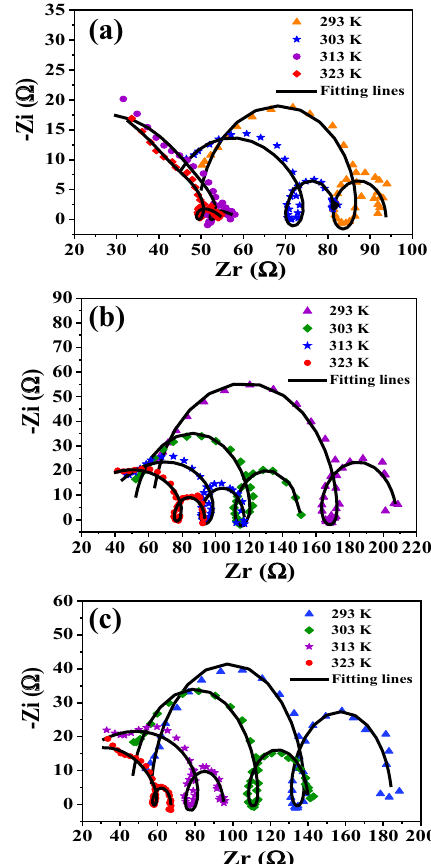
Figure 8. Nyquist plots for Al immersed in 0.1 M NaOH in the absence and presence of 300 ppm of Cefx and Cefz drugs at different temperatures (from 293 to 323 K): ( a ) Blank, ( b ) Cefx and ( c ) Cefz.